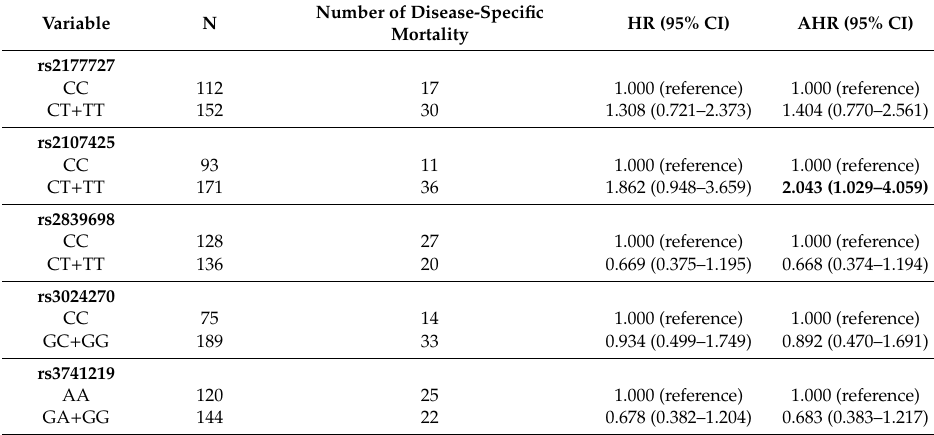
Table 5. Risk of disease-specific mortality on genotype distributions of H19 gene polymorphisms among 264 UCC patients over 65 years old.